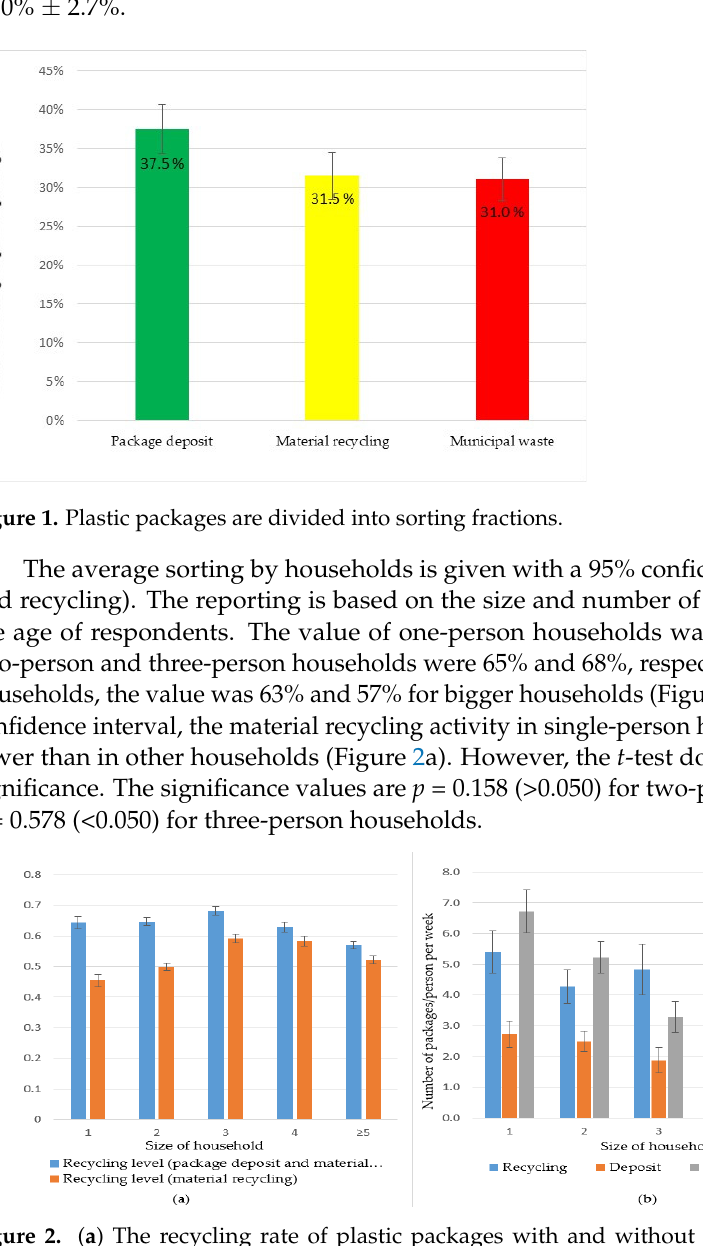
Figure 2. ( a ) The recycling rate of plastic packages with and without deposit in various-sized households; ( b ) The impact of household size on the recycling rate of food packages.